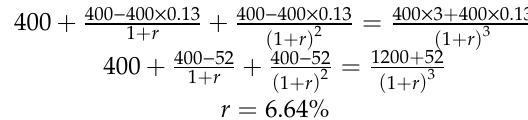
Table 6. Comparative E ffi ciency of Investment in Government Bonds and Deposits, % per year. Indicator Deposits Bonds Average Yield Yield of the IIA Average Yield with IIA Benefits Included Average Inflation rate Average Inflation-Adjusted Yield 0.86 6.92 Additional Risks - Market Risk, Reinvestment risk, Operational Risk Source: compiled by the